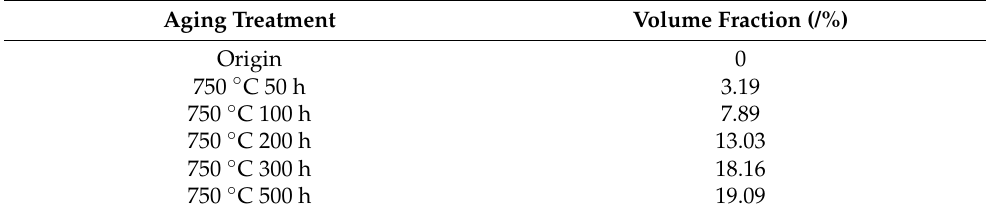
Table 1. Volume fraction of the